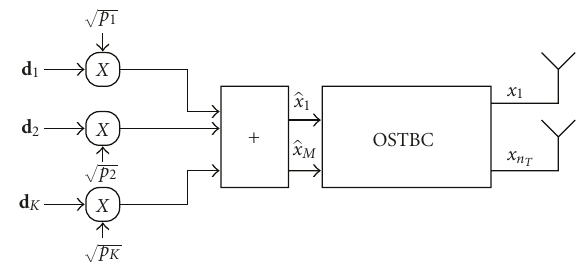
Figure 2: Transmitter